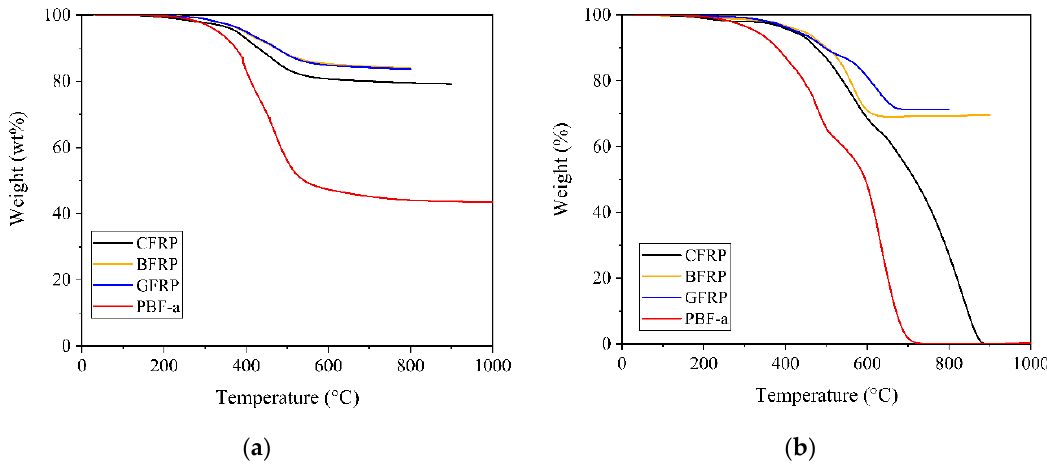
Figure 5. Weight-temperature curves of neat PBF-a as well as carbon, glass and basalt fiber reinforced PBF-a under ( a ) nitrogen and ( b ) ambient atmospheres.